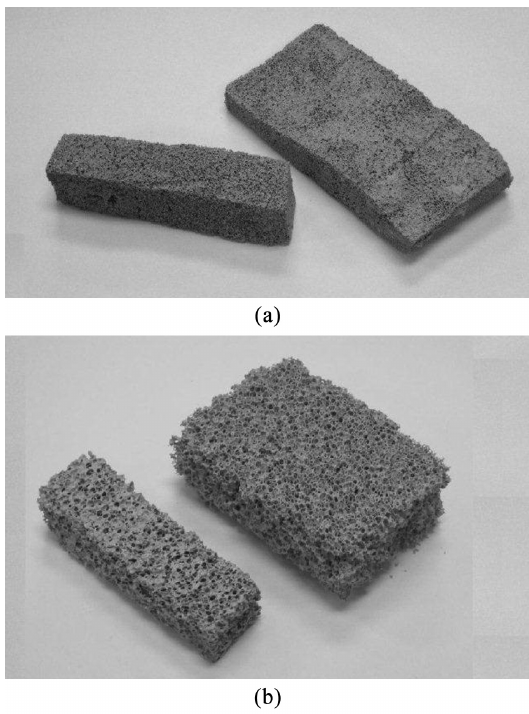
Figure 4. Morphology of acicular growth of mullite observed through confocal